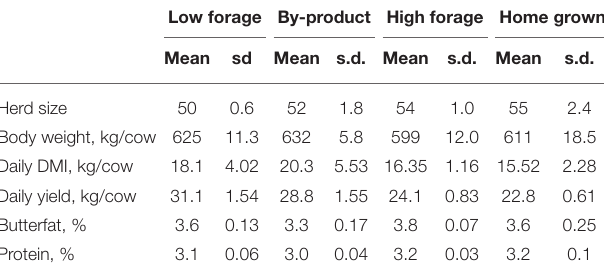
TABLE 3 | Average annual dairy system production characteristics for control merit cows. Low forage By-product High forage Home grown